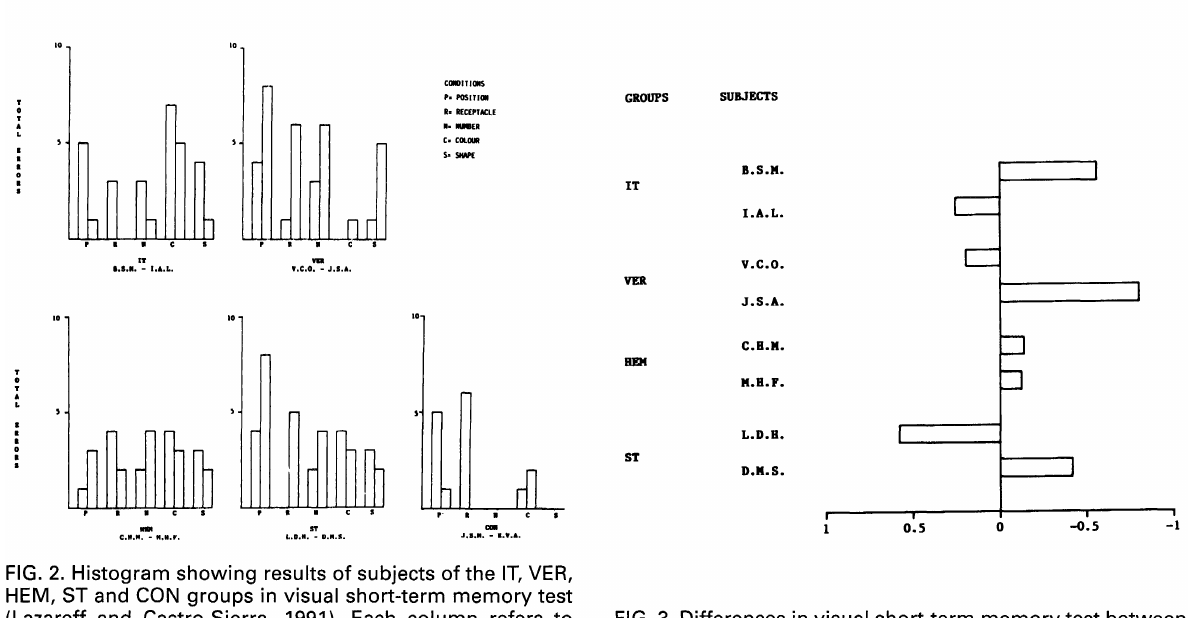
FIG. 3. Differences in visual short-term memory test between individual patients' scores and control subjects' average scores plotted in terms of S.D.